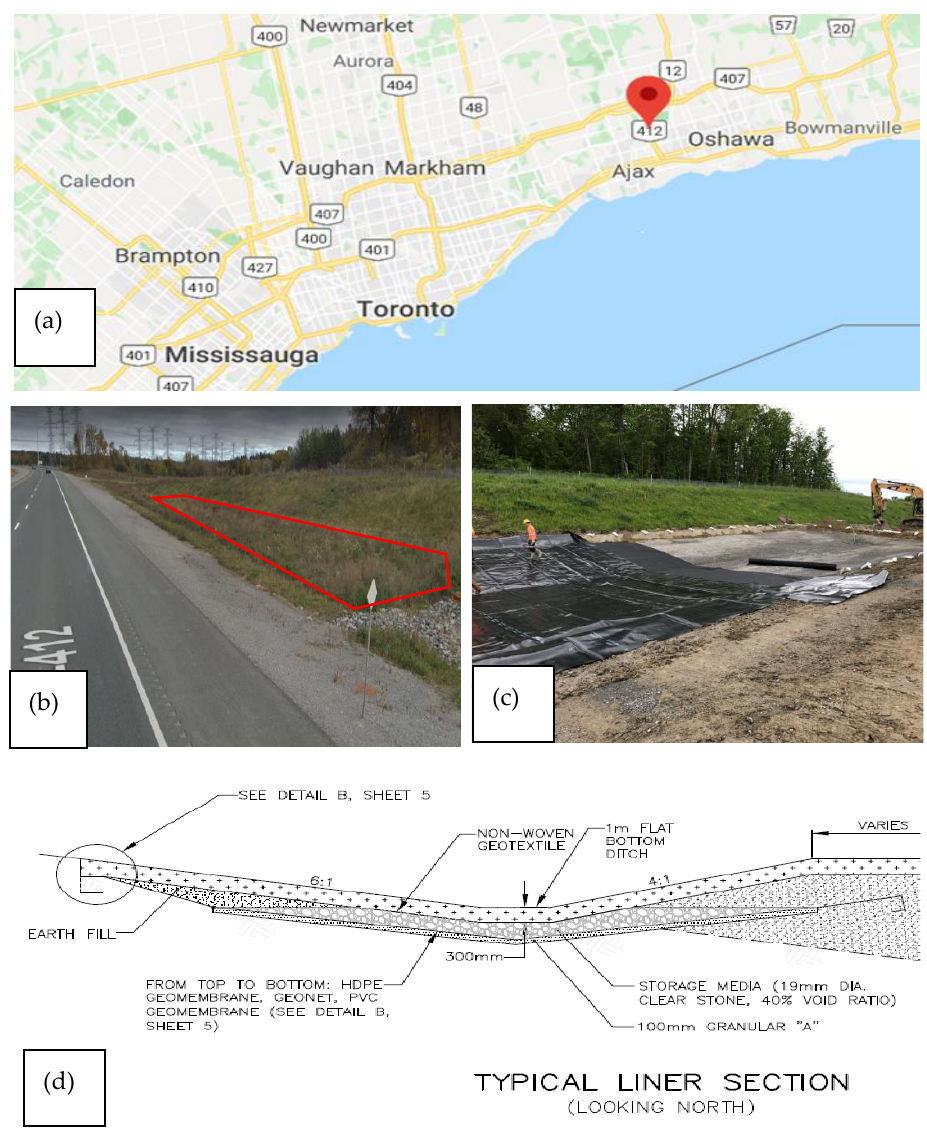
Figure 2. ( a ) Study site location; ( b ) Roadside ditch; ( c ) Photo of the ERDS during the installation; ( d ) Cross-section of the ERDS.